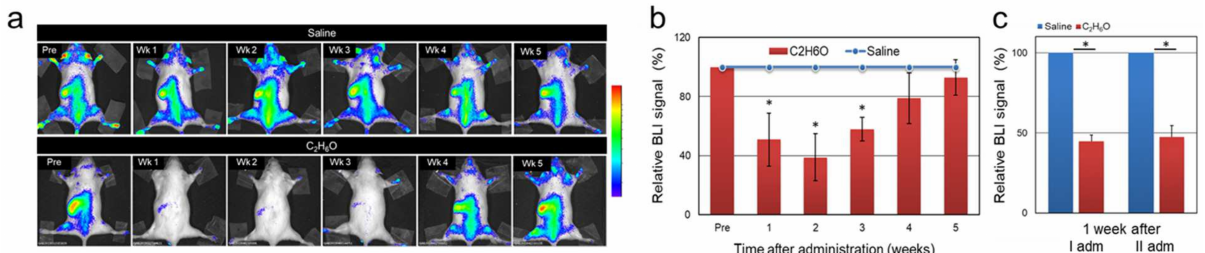
Figure 2. Kinetics of the response of NF-Y-dependent cell proliferation to acute ethanol administration in the MITO- Luc mouse model. Longitudinal BLI imaging performed at different time points after administration on MITO-Luc mice administered with either vehicle (saline) or ethanol solution. Luciferase emission was determined by BLI in ( a ) a representative animal and ( b ) in each acquisition, regions of interests countering the whole animal were delineated and BLI emission quantified using the Living Image software. The graph illustrates BLI signal intensities relative to saline control levels set as 100%. ( c ) MITO-Luc mice were administered with either vehicle or C 2 H 6 O solution; after 8 weeks of recovery, the administration was repeated at the same dose. Quantification of the BLI signals was performed 1 week after each administration The pseudo-color scale bar indicates the relative signal intensity from the lowest (blue) to the highest (red) (range 1 × 10 4 –1 × 10 5 photons/s/cm 2 /sr). The asterisk (*) indicates a statistically significant difference compared with the relative saline